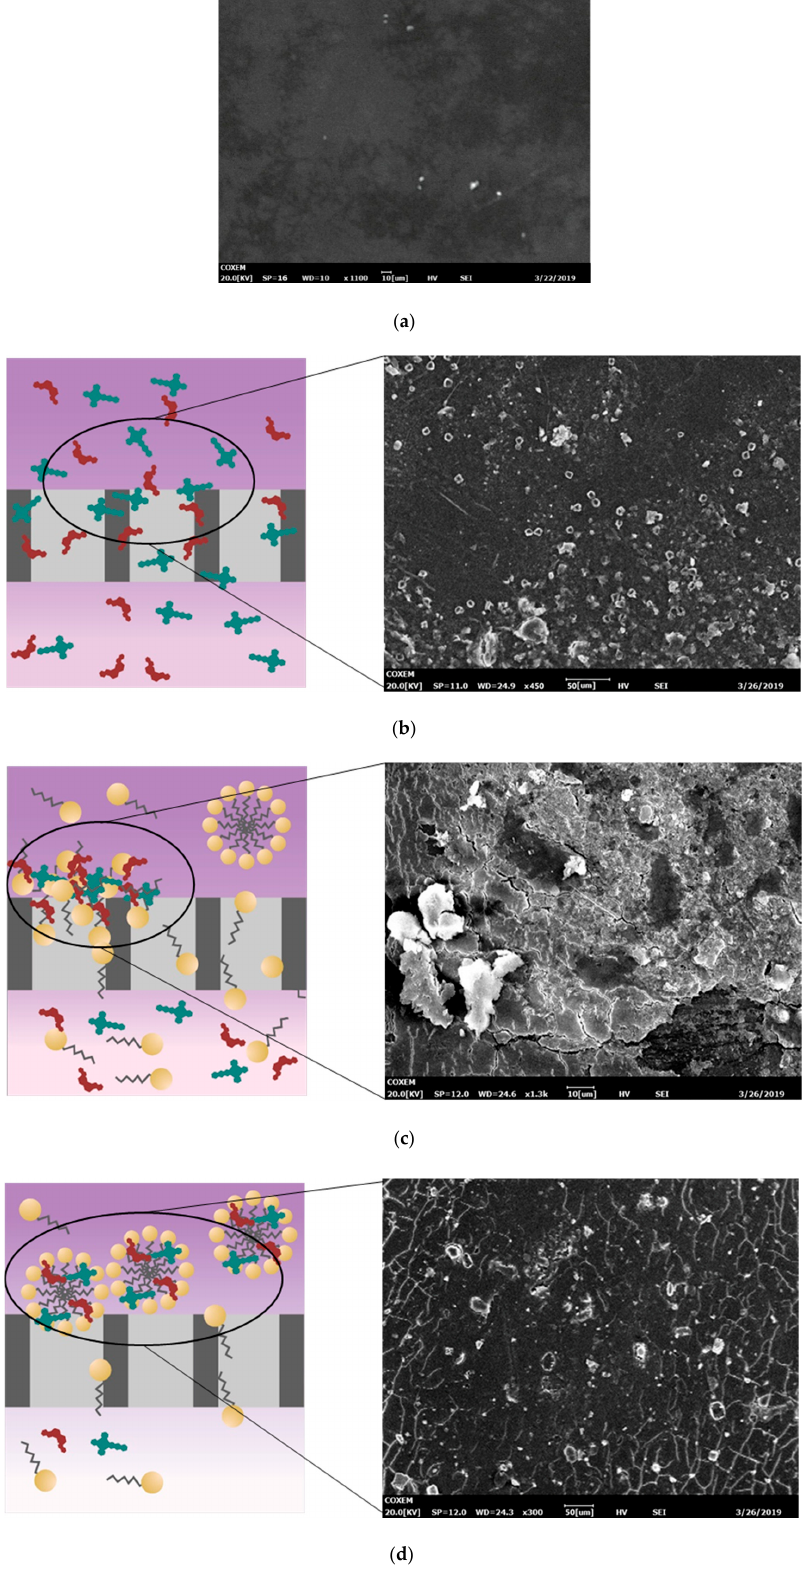
Figure 6. Illustration of membrane blocking and membrane surface SEM images of ( a ) clean membrane, and fouled membrane, ( b ) without saponin, ( c ) with saponin under CMC, and ( d ) with saponin above CMC.